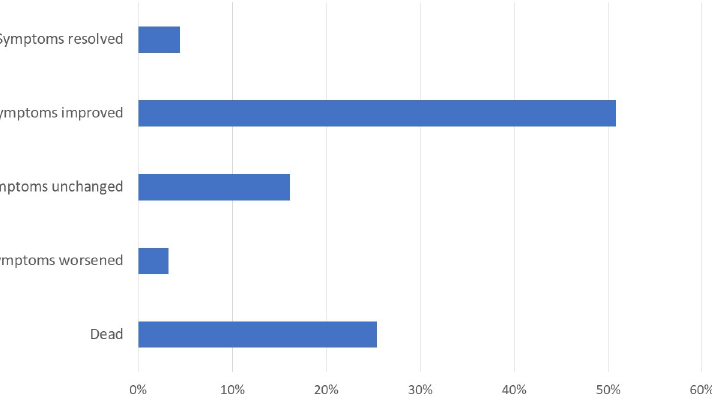
Fig 1. Thirty-day outcomes among patients diagnosed with heart failure in a Tanzanian emergency department, 2018–2019 (n =